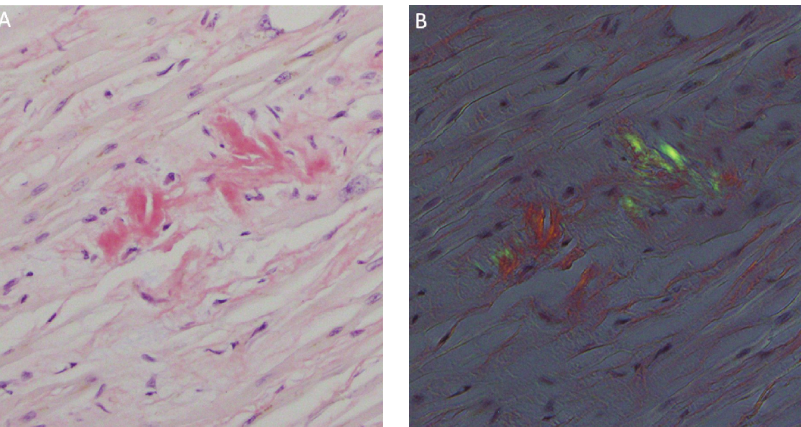
Figure 1: Cardiac amyloidosis. (A) Congo red stain of left ventricle showing focal positive staining (red-orange) of amorphous extracellular material, 400x. (B) Congo red stain of left ventricle showing apple-green birefringence under polarized light, diagnostic of amyloid,